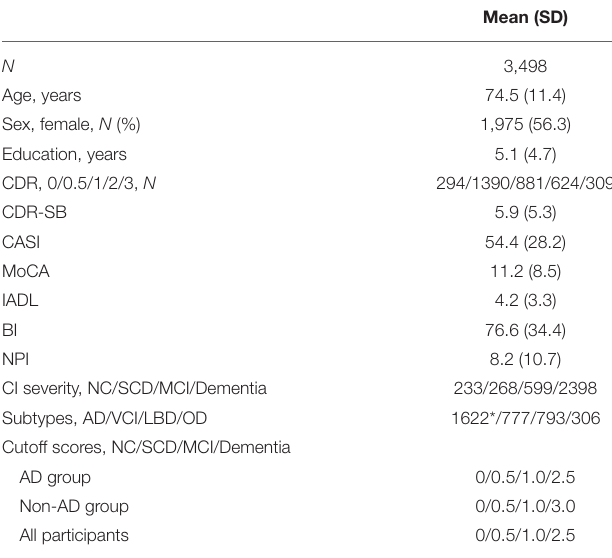
TABLE 1 | Demographic data of the participants in the design